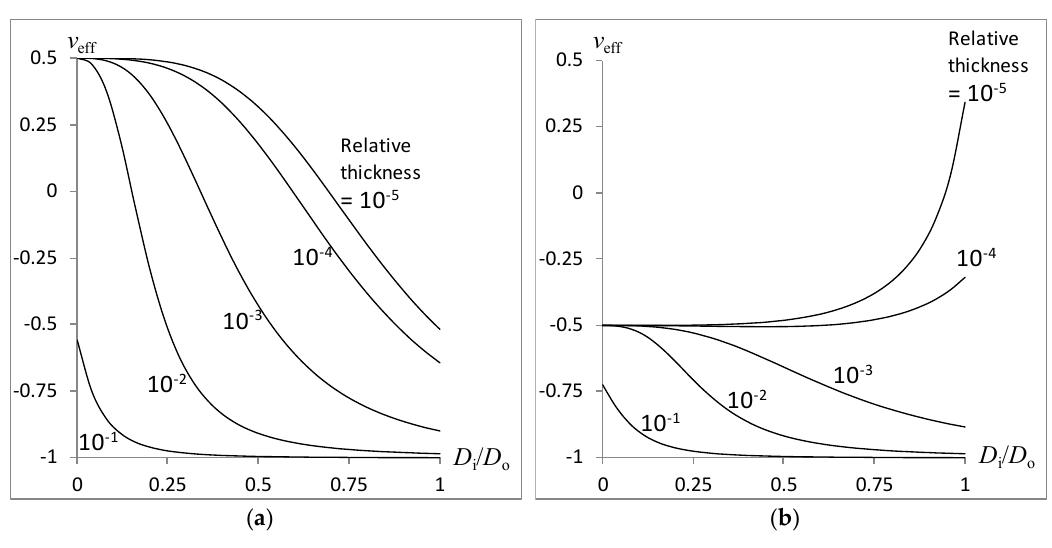
Figure 5. Effect of relative adhesive thickness on the compound rod auxeticity: ( a ) Auxetic core; ( b ) Auxetic shell.